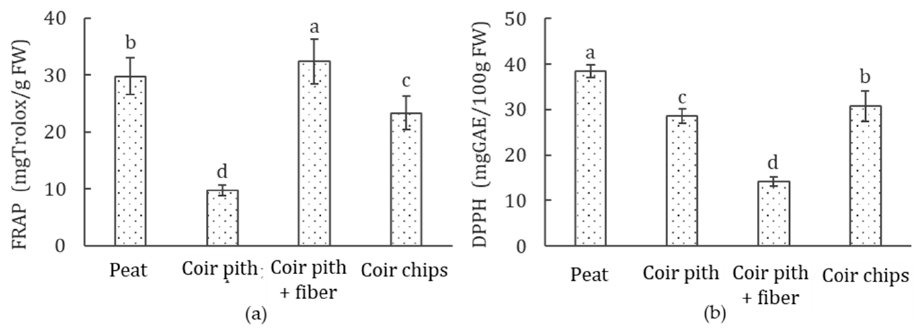
Figure 7. FRAP ( a ) and DPPH ( b ) in the leaf blade. Means with different letters are significantly different at p < 0.05; FW—fresh weight. Each bar represents the mean of five replicates, and the error bars represent ± 1SE.